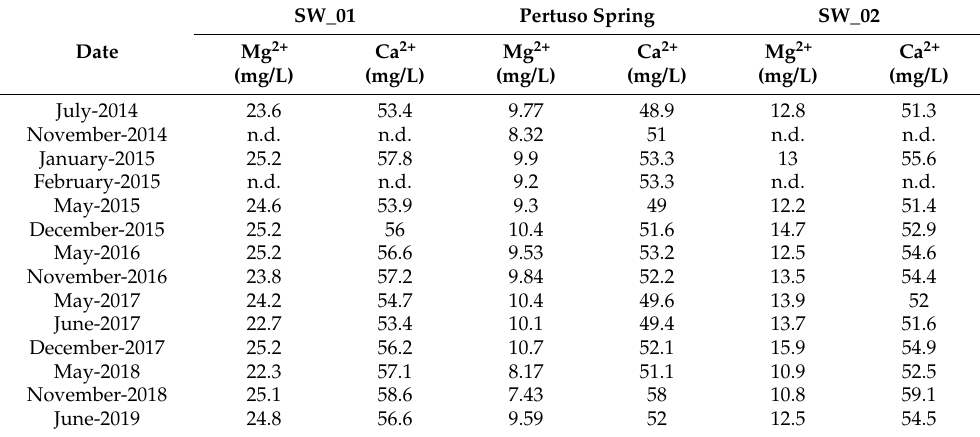
Table 1. Mg 2+ and Ca 2+ ions concentration in monitoring point water samples.